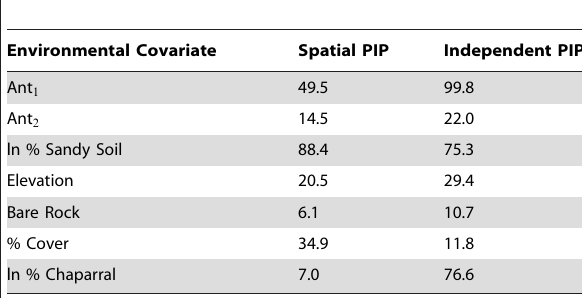
Table 4. Posterior inclusion probabilities (PIP) for the California lizard